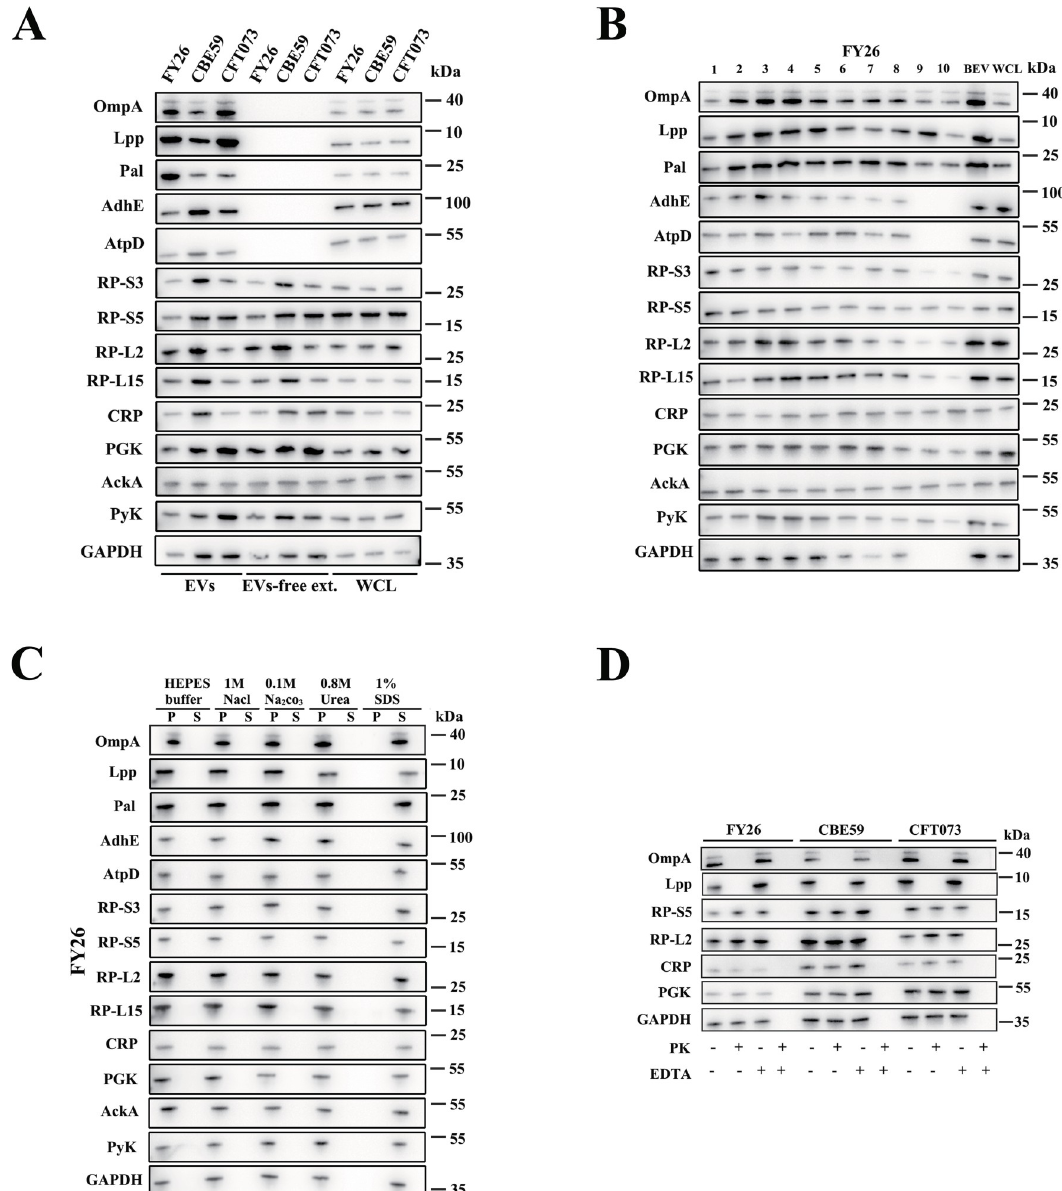
Fig 4. Detection of membrane and cytoplasmic proteins in density gradient ultracentrifugation (DGU)-purified ExPEC EVs. (A) Expression of membrane and cytoplasmic proteins in EVs and EV-free extracellular medium of ExPEC strains was determined with western blotting. Total protein (1 μ g) was loaded into the OmpA and Gapdh lanes, and 5 μ g of total protein was loaded into the other lanes. Molecular weight markers are shown on the right. (B) Expression of membrane and cytoplasmic proteins in DGU- purified EVs (F1–F10) was determined with western blotting. Nonfractionated EVs were used as the positive controls, and whole-cell lysates (WCLs) were used as the loading controls. Total protein (1 μ g) was loaded into the OmpA and Gapdh lanes, and 5 μ g of total protein was loaded into the other lanes. (C) Dissociation assays confirmed that the protein cargoes were tightly associated with the EVs of the ExPEC strains. OptiPrep-purified EVs were treated with HEPES buffer containing the indicated chemical agents or with HEPES buffer only. The pellets (P; containing EVs) and extracellular media (S; containing proteins released from EVs) were collected by ultracentrifugation, and the samples were analyzed with western blotting. Total protein (1 μ g) was loaded into the OmpA and Gapdh lanes, and 5 μ g of total protein was loaded into the other lanes. (D) Immunoblots of proteinase K (PK)-untreated (PK-) and PK-treated (PK+) ExPEC EVs either intact (EDTA+) or lysed with 0.1 M EDTA (EDTA+) with the indicated antibodies.